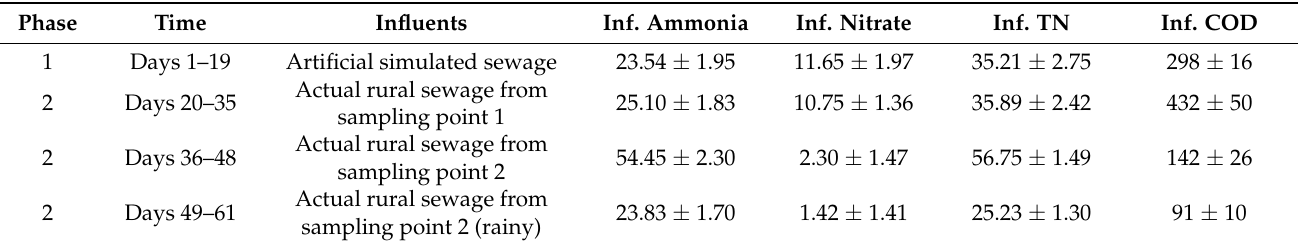
Table 1. Influents of the WRBC system in phases